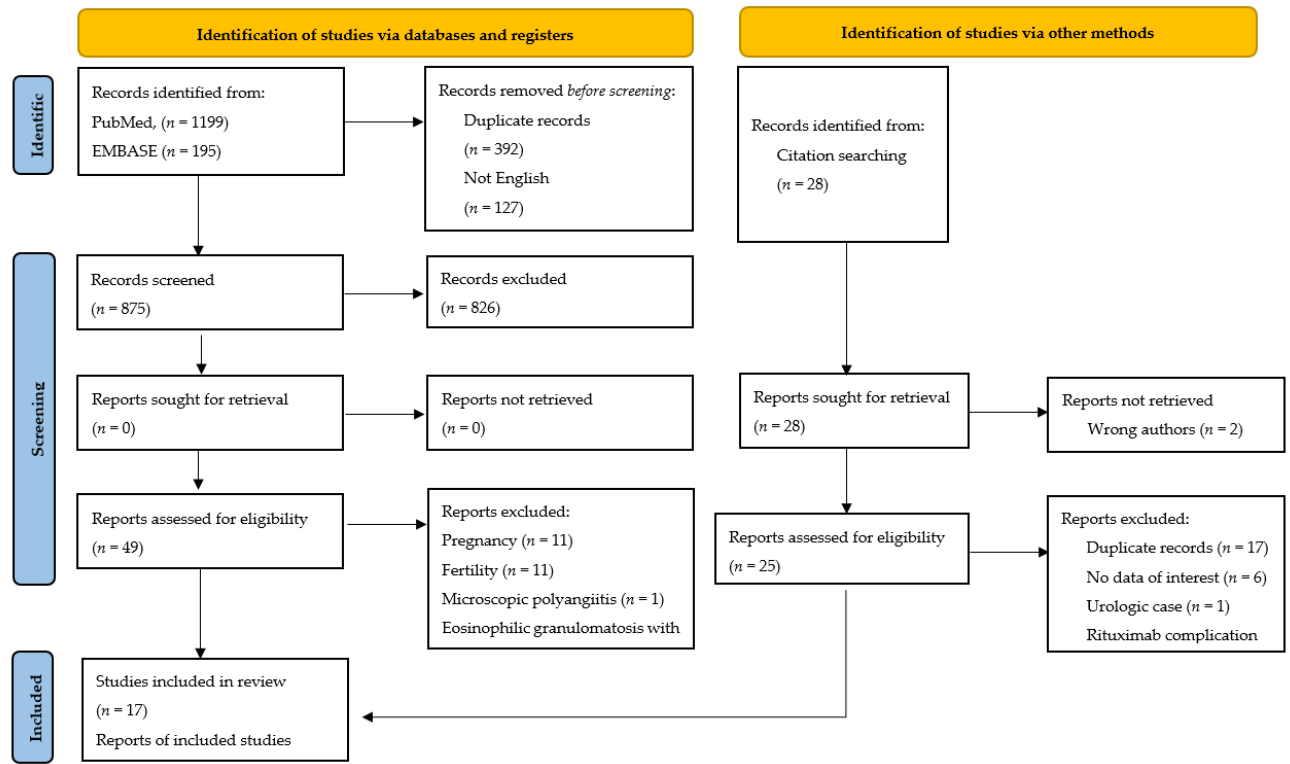
Figure 1. Flow diagram of study search and systematic review.